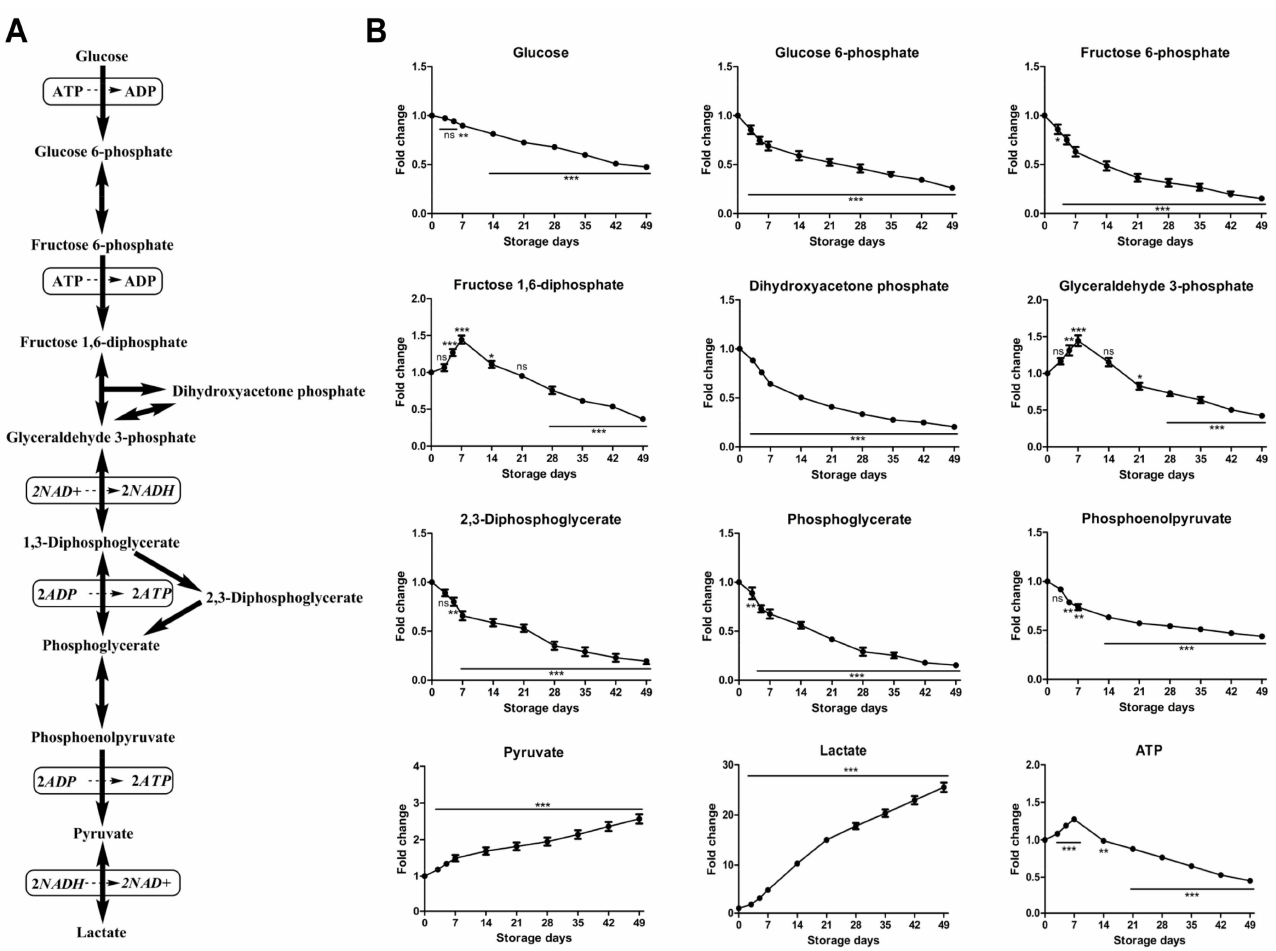
Figure 2. An overview of glycolysis ( A ) and time-course changes of metabolites involved in this pathway ( B ) during RBC storage in MAP. Fold change was normalized against day 0 controls. Data are mean ± SD ( n = 8); * p < 0.05, ** p < 0.01, *** p < 0.001, ns (not significant), compared with day 0